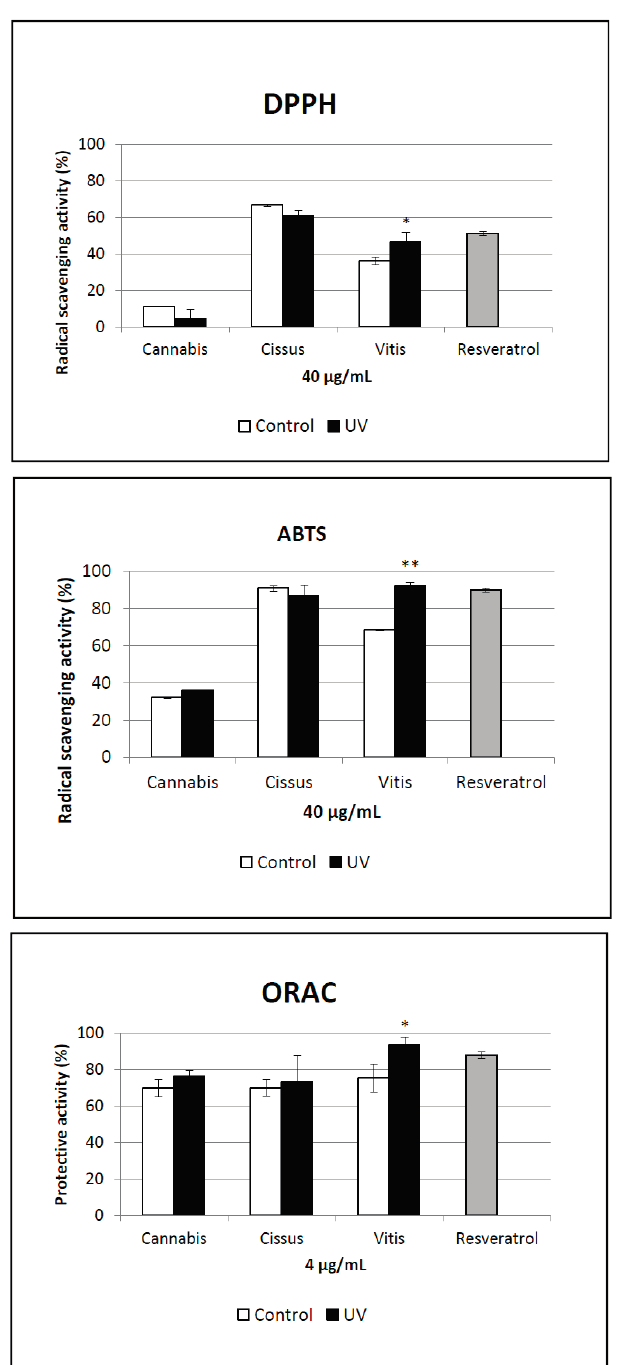
Figure 4. Antioxidant activity of plant extracts compared to resveratrol as positive control. UV indicates plants exposed to UV light, and control indicates non-exposed plants. * Significantly different from control ( p ≤ 0.05); ** Significantly different from control ( p ≤